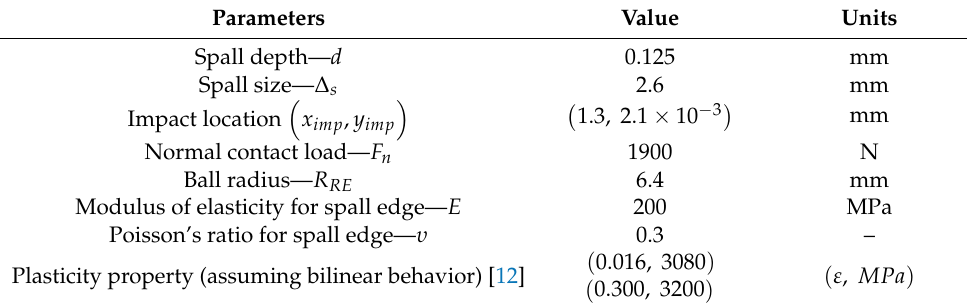
Table 1. FE model parameters and material properties (for M50 steel).